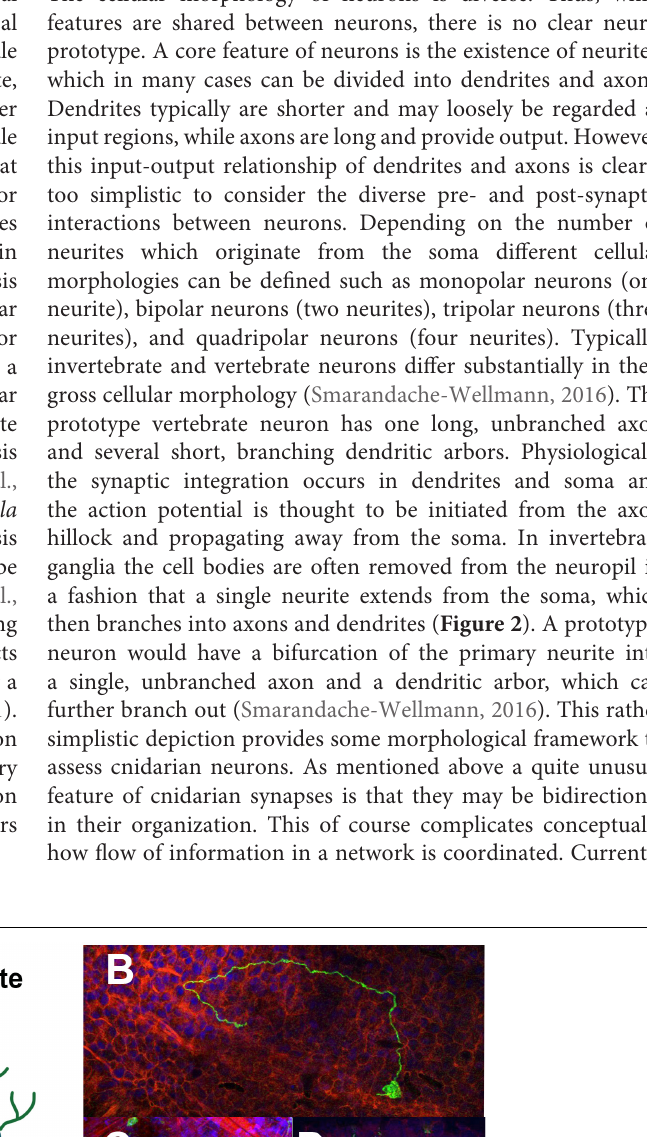
Frontiers in Neuroscience |